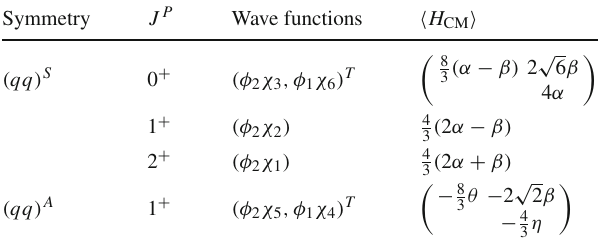
Table 1 The quantum numbers, color–spin wave functions, and the corresponding CMI matrices for the nn ¯ c ¯ c , nn ¯ b ¯ b , ss ¯ c ¯ c , and ss ¯ b ¯ b sys- tems. Here, ( qq ) S ( ( qq ) A ) means that the flavor wave function of the two light quarks is symmetric (antisymmetric) Symmetry J